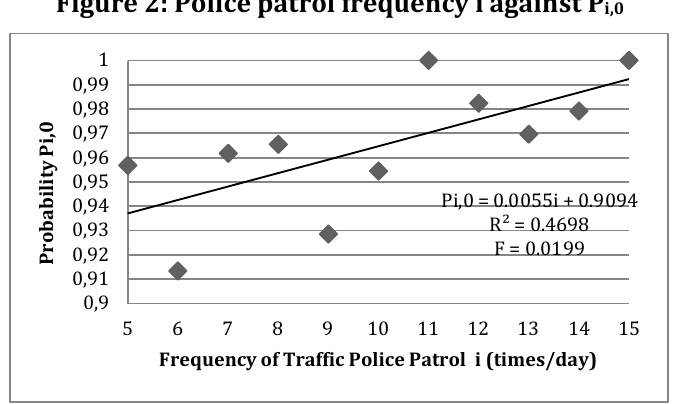
Figure 2: Police patrol frequency i against P